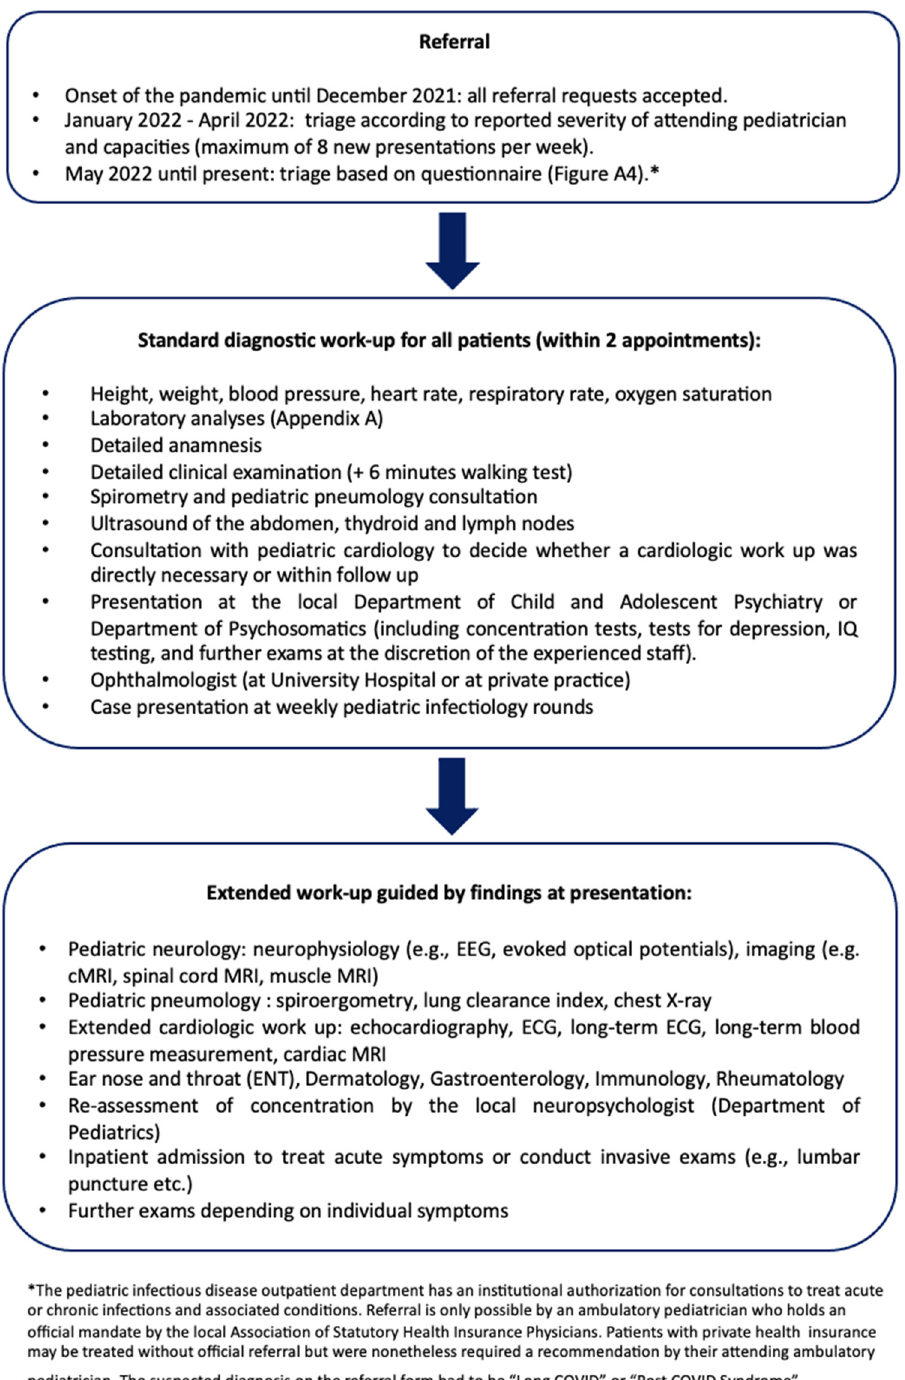
Figure 1. Referral and diagnostic procedure at the Long COVID Outpatient Department at the University Hospital Essen (see Appendix B, Figure A2 for the referral request form) Self-reported symptoms Amenorrhea was defined as at least three consecutive missed menstrual cycles. Ex- ercise intolerance was defined as a pathological score in the six minutes walking test (pathological testing equaled: discontinuation due to persisting discomfort, tachycardia, drop in saturation, hypo/hypertension, pathological blood gas analysis). Furthermore a